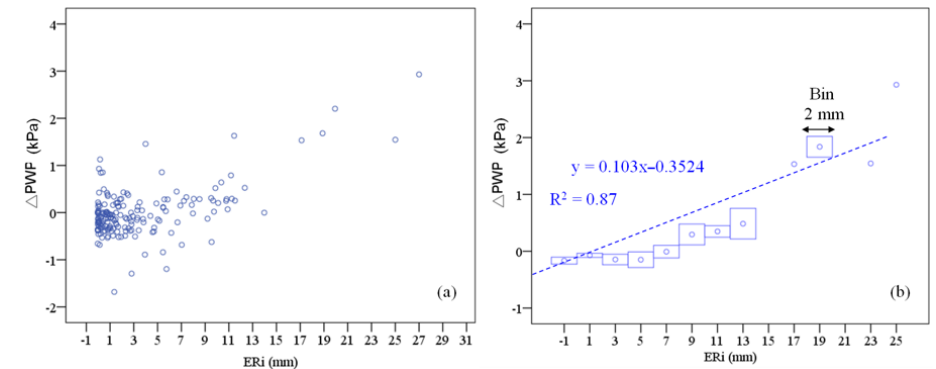
Figure 8. (a) Daily equivalent rainfall (ER i ) vs. daily change of pore water pressure (PWP i ) in absolute values for 13 months (Septem- ber 2009–February 2010 and May–November 2010). (b) PWP i has been aggregated in bins of mean values for discrete steps of daily equivalent rainfall (mean + 1 sigma error).